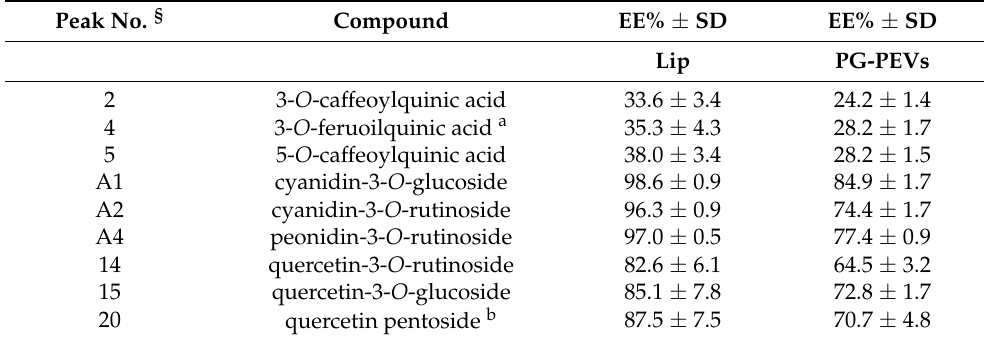
Table 6. Entrapment efficiency (EE %) of P. spinosa fruit extract nanoformulations. Data are given as means ± standard deviations (SD); n =